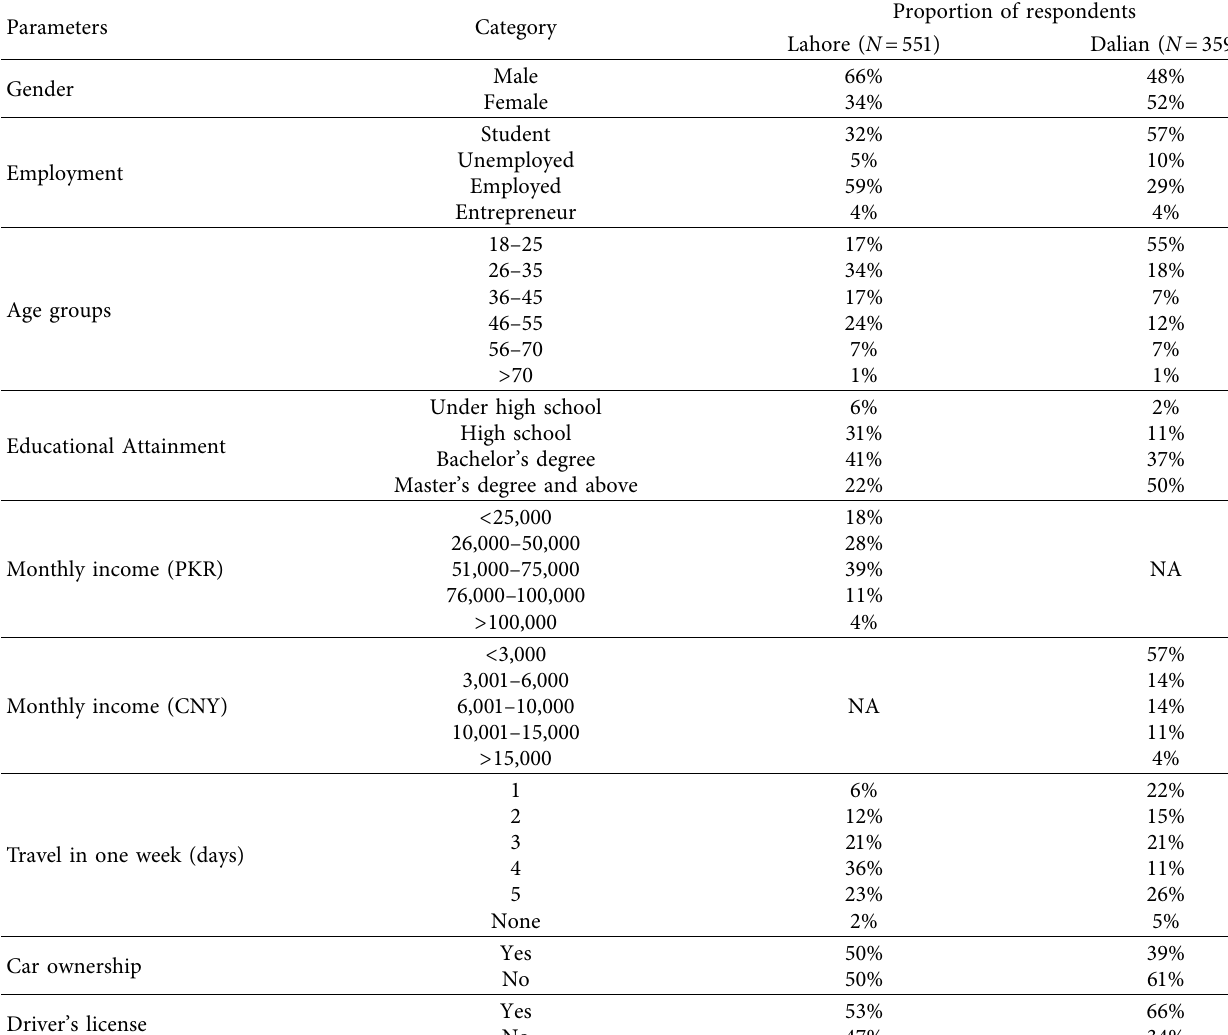
Table 5: A summary of the sociodemographic characteristics of respondents in Lahore and